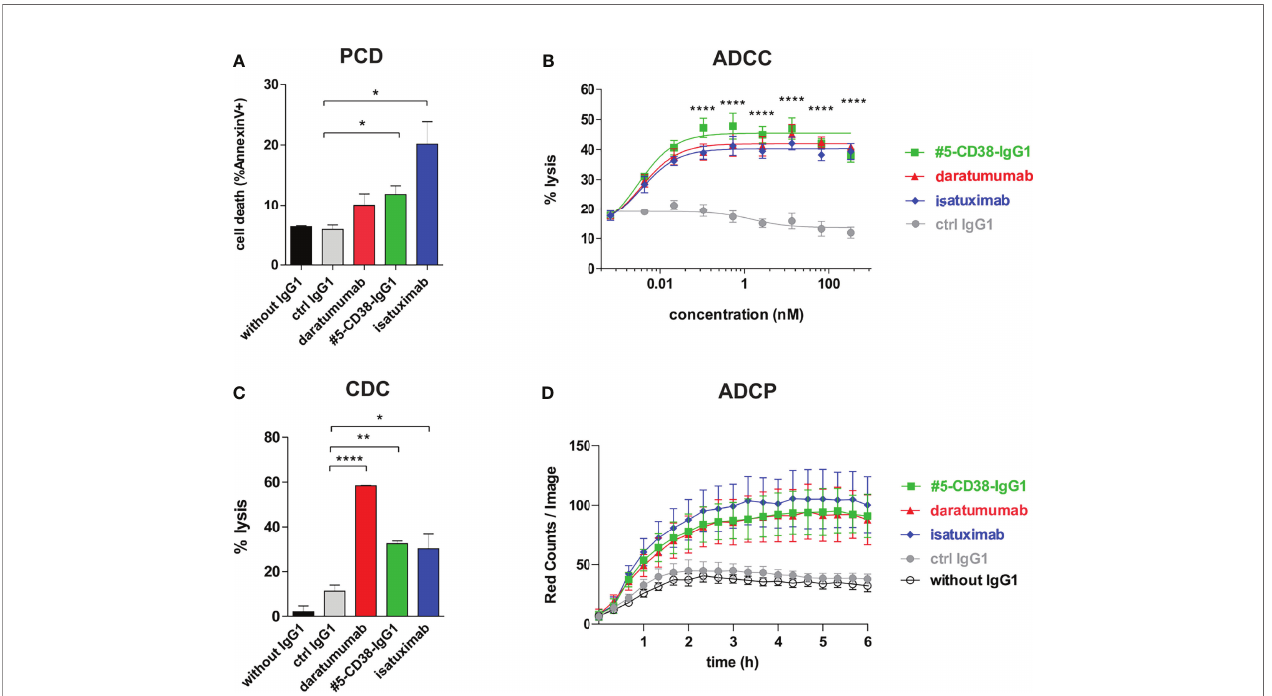
FIGURE 6 | Functional characterization of #5-CD38-IgG1. (A) To measure the induction of PCD, 0.5 x 10 6 Daudi cells were incubated with 1 µg/ml of the indicated antibodies for 20 h and afterwards stained with Annexin V-FITC and 7-AAD. Dead cells are shown as mean percentage of total Annexin V-positive cells ± SEM from three independent experiments. *p ≤ 0.05 CD38 antibodies vs. control IgG1. (B) ADCC was measured by standard 4 h chromium release assay using L-363 cells as target cells and PBMC of healthy donors as effectors cells in an effector-to-target cell (E:T) ratio of 80:1. Mean percentage of lysis ± SEM from six experiments with different PBMC donors are shown. ****p ≤ 0.0001 CD38 antibodies vs. control IgG1. (C) CDC was also measured by chromium release assay using 25% (v/v) serum of healthy donors and CD38-positive Daudi cells as targets. Mean percentage of lysis ± SEM from three independent experiments are shown. *p ≤ 0.05, **p ≤ 0.01, ***p ≤ 0.001 CD38 antibodies vs. control IgG1. (D) ADCP was measured by live cell imaging using pHrodo-labeled L-363 cells and macrophages generated from healthy donors in an E:T ratio of 1:1 with 10 µg/ml of the indicated antibodies. Phagocytosis was measured as red counts per image. Mean values ± SEM from four independent experiments are